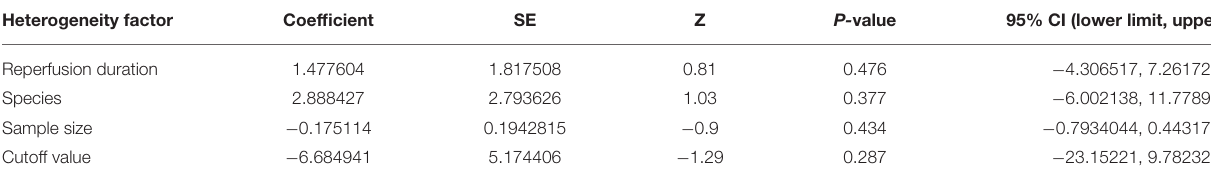
TABLE 3 | Meta-regression analysis of potential sources of heterogeneity.